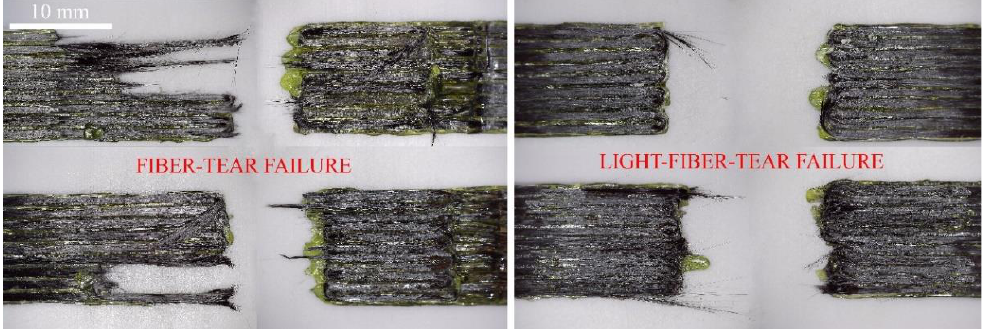
Figure 8. Observed failure modes.